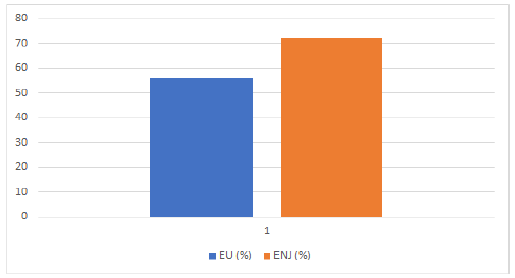
Figure 10. Quantitative factors of the study. Figure 7. Quantitative factors of the